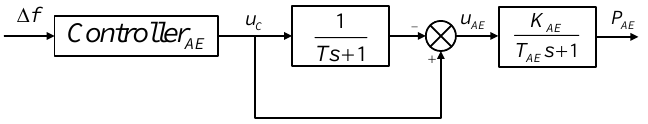
Figure 6. Aqua Electrolyzer Supplementary Control Block.